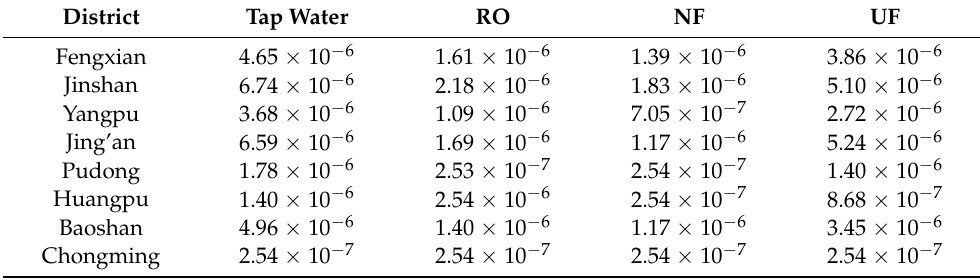
Table 4. Carcinogenic risk at different concentration levels in each zone (year − 1 ).